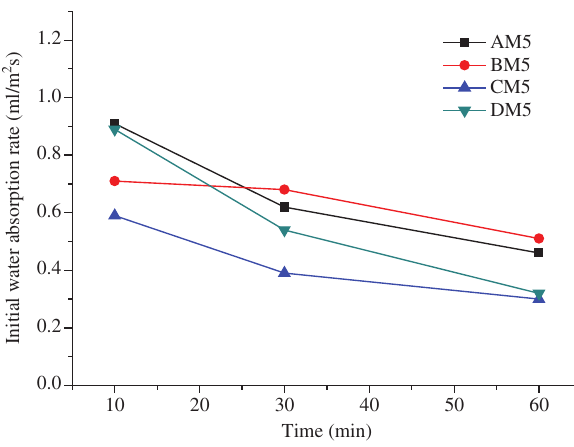
Figure 9: Initial surface absorption of AAFA geopolymer with the alkaline solution/binder ratio of 0.5 vs. time.